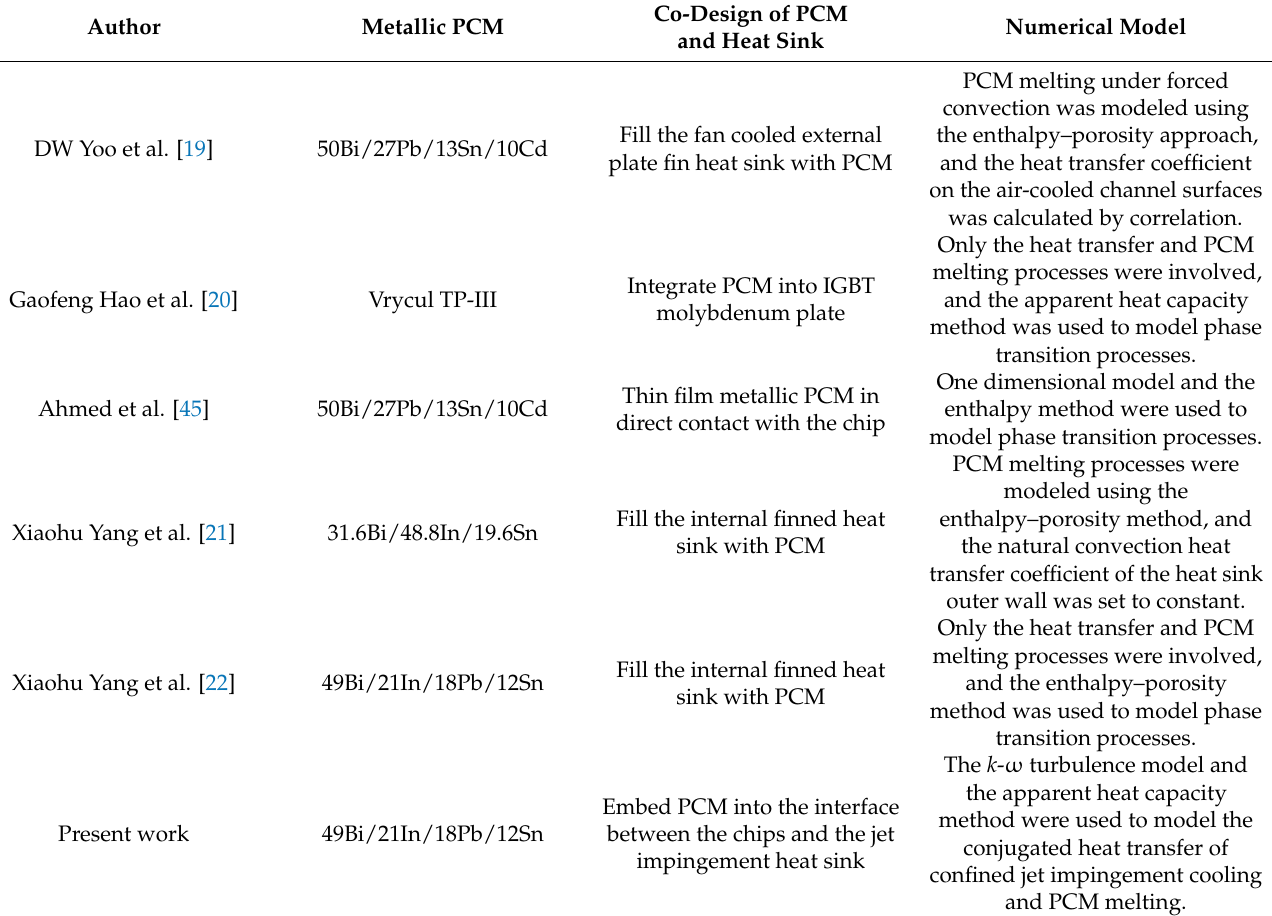
Table 3. Comparison of the current study with other existing numerical